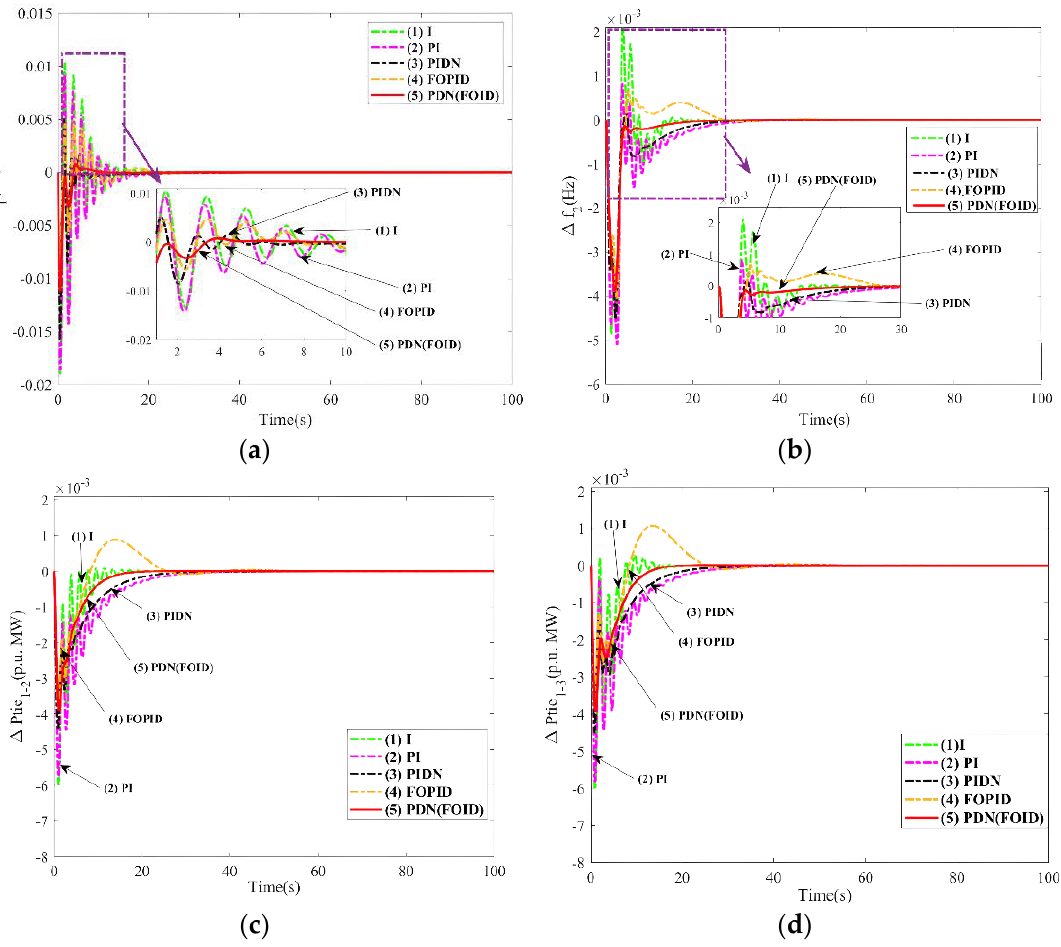
Figure 5. Evaluation of outcomes of subordinate controllers for scheme-1 for 1% step load disorder contrast time: ( a ) Anomaly of frequency of area-1, ( b ) Anomaly of frequency of area-2, ( c ) Anomaly of Tie-line power interlinking area-1 and area-2, ( d ) Anomaly of Tie-line power interlinking area-1 and area-3. Table 1. Finest values of gains and related parameters of subordinate controllers for scheme-1.